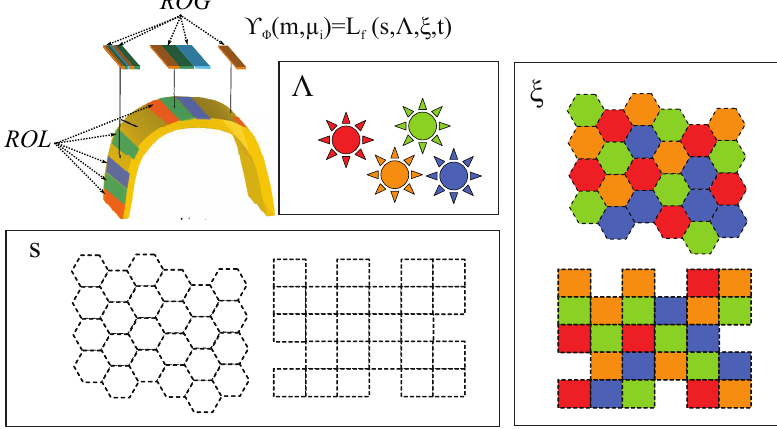
Figure 8. Parameters s , ∆ , ξ of the transformation Υ Φ